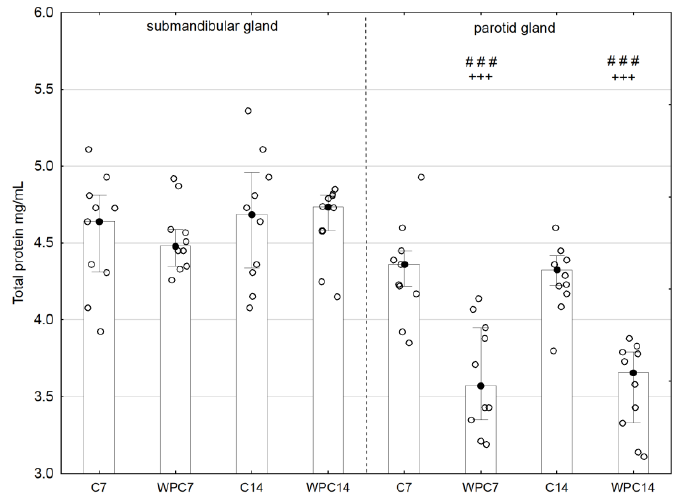
Figure 2. Total protein concentration of the submandibular and parotid glands of rats from control and experimental groups. Abbreviations: C7, C14, control groups; WPC7, WPC14, experimental groups treated WPC-80. Data are presented as a bar chart with the individual data points; +++ p < 0.001 of the C14 submandibular gland and ### p < 0.001 of the submandibular gland, respectively, for the same groups. Because the results were not normally distributed, the Mann-Whitney test was used to compare differences between the studied groups.